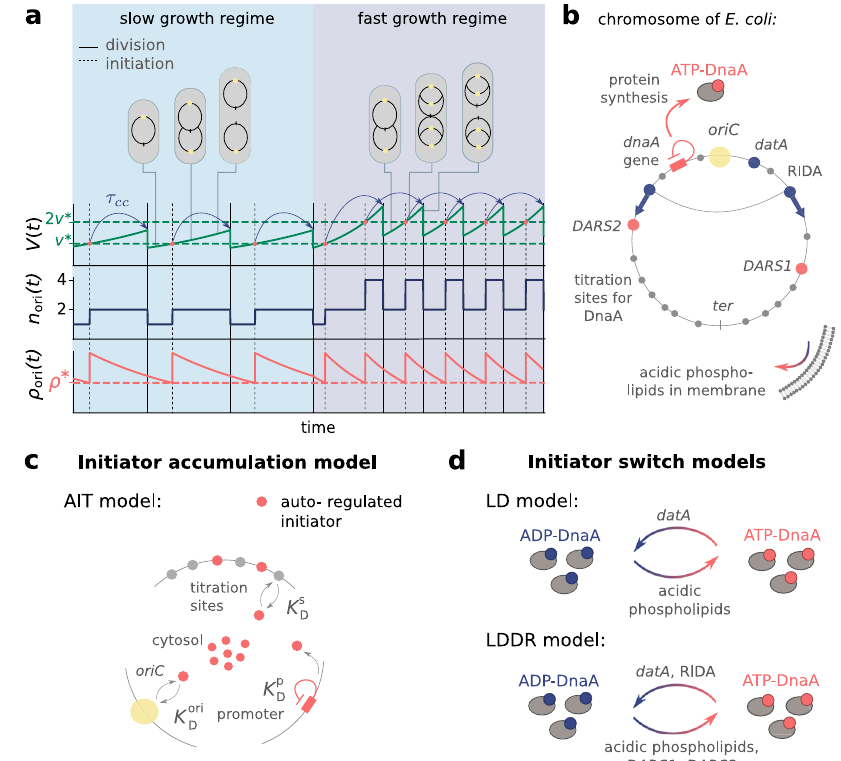
Fig. 1 | We present two distinct models to elucidate the molecular mechanism by which E. coli initiates replication at an on average constant volume per origin. a The volume V ( t ), the number of origins n ori ( t ) and the origin density ρ ori ( t )= n ori ( t )/ V ( t ) as a function of time. Initiating replication at a constant origin density ρ * (dashed red line) or respectively a constant volume per origin v * =1/ ρ * (dashedgreenline)anddivisionaconstanttime τ cc later(bluearrows)ensuresthat the cell initiates replication once per division cycle and that it maintains cell size homeostasis at slow (light blue regime) and fast (dark blue regime) growth rates. b Schematic representation of an E. coli chromosome: Replication starts at the origin ( oriC , yellow circle) and proceeds via two replication forks to the terminus (ter, gray bar). Replication is initiated by the ATP-bound form of the initiator